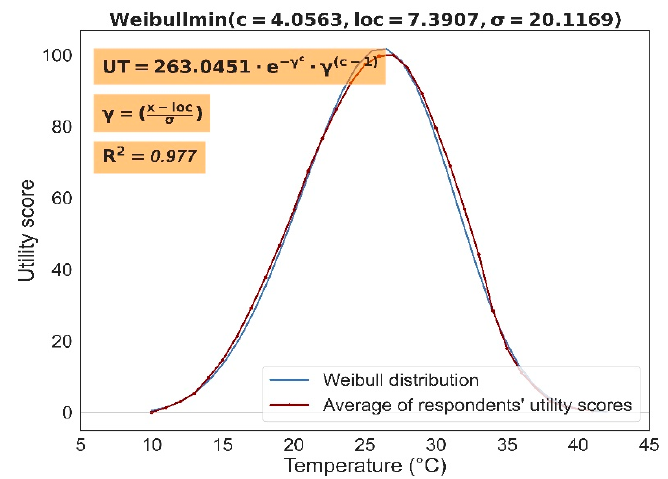
Figure 7. Empirical utility function for ambient air temperature in urban tourism.